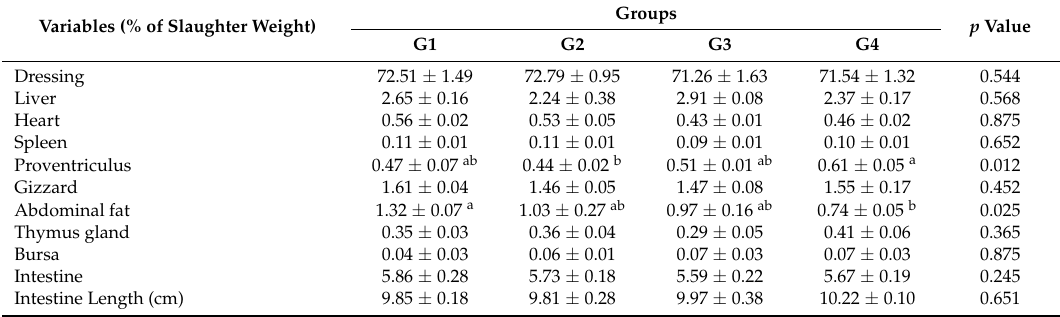
Table 6. Effect of dietary supplementation of C. butyricum and S. cerevisiae on some carcass traits in broiler